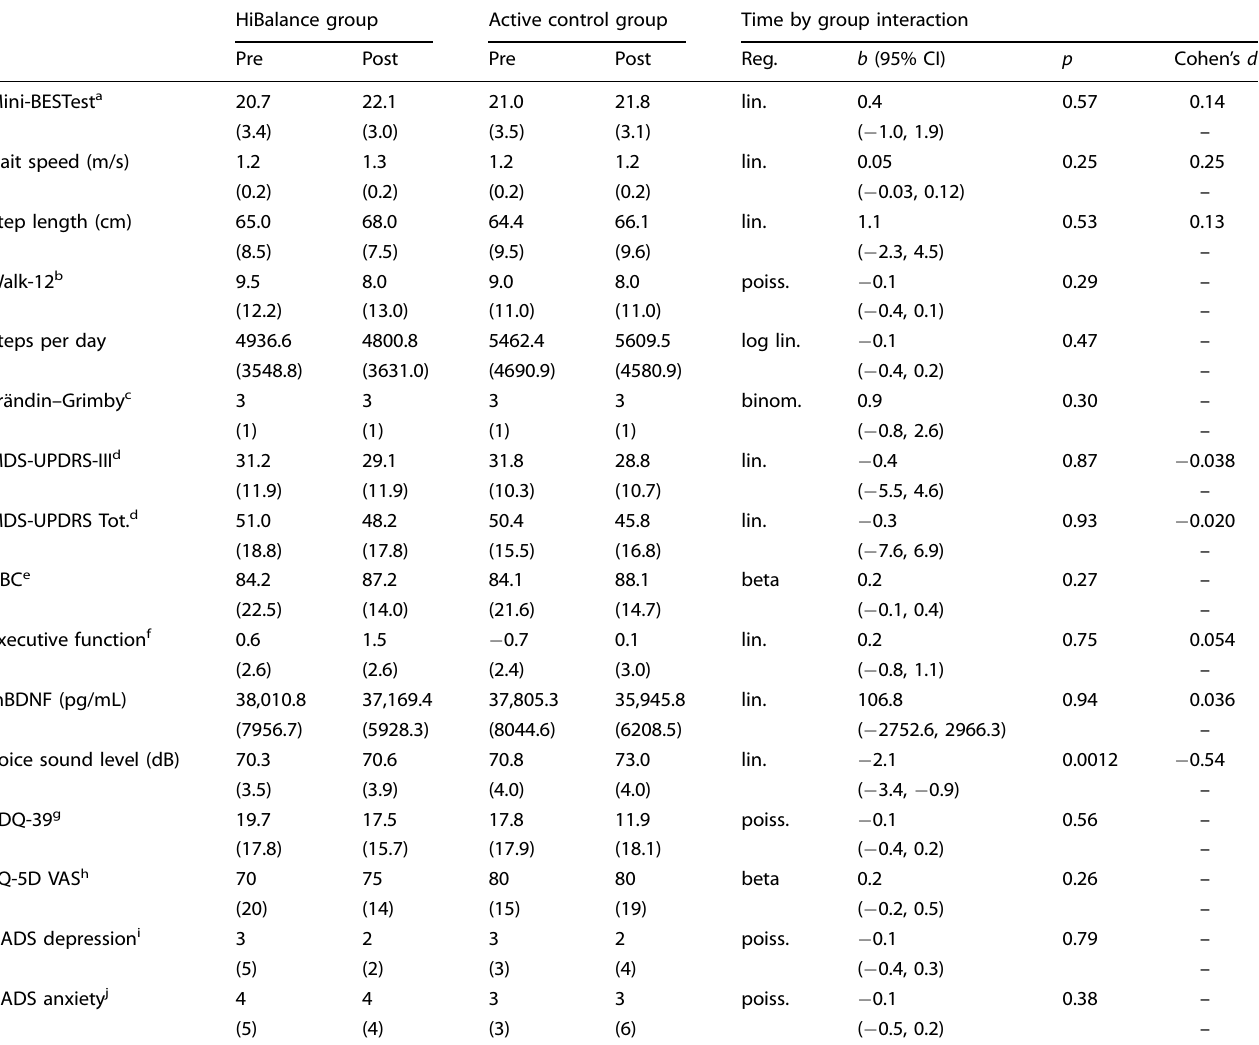
Table 2. Descriptive data (observed values) and analyses estimates (by intention to treat) for the behavioural outcomes and